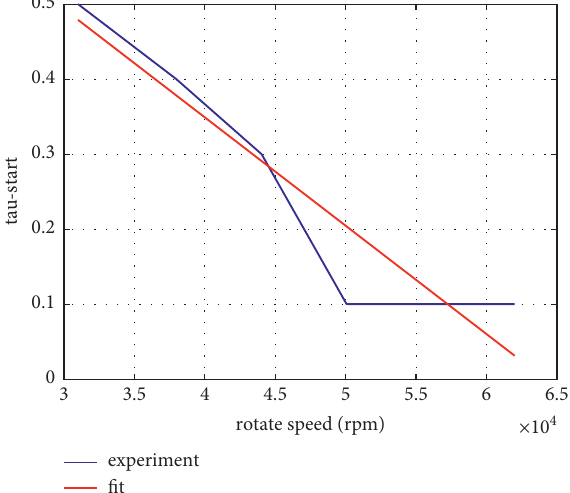
Figure 6: Comparison between fitted time delay parameter and experimental data.